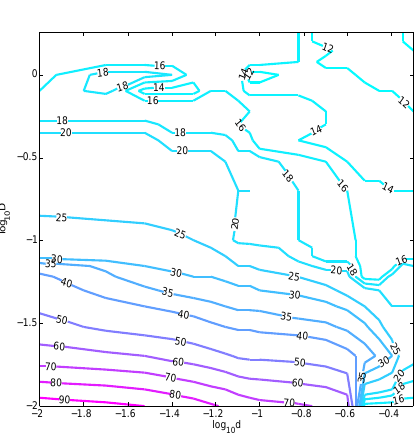
We made these tests with d varying from 0 . 01 to 0 . 5 . Even for d = 0 . 01 , the truncation order L max = 15 lead to an error smaller than ε = 10 − 6 (see Figure 5).